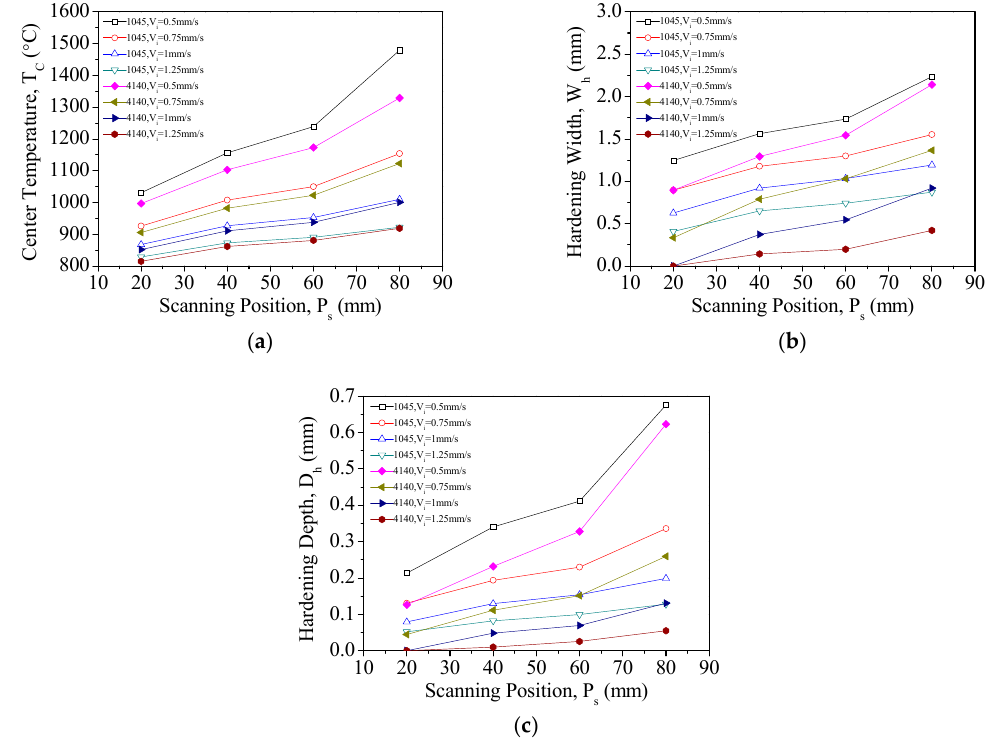
Figure 14. ( a ) Relationship between temperature and scanning position for a laser power of P i = 200 W; ( b ) relationship between hardening width and scanning position for a laser power of P i = 200 W; and ( c ) relationship between hardening thickness and scanning position for a laser power of P i = 200 W.